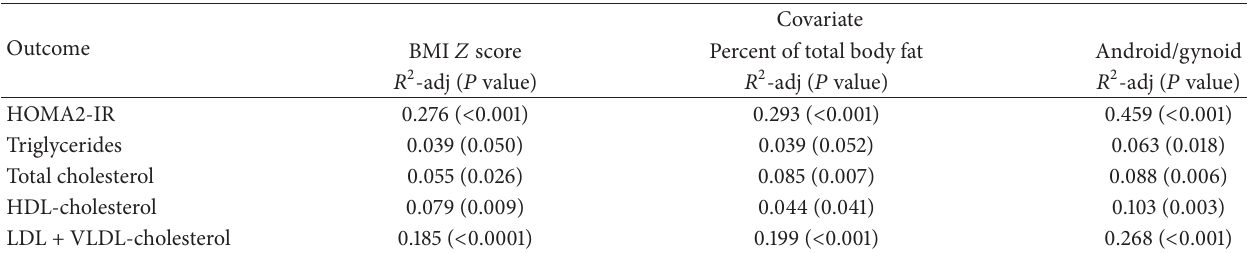
Table 2: Regression based correlation analyses adjusted 𝑅 2 for each outcome, HOMA2-IR, triglycerides, total cholesterol, and HDL- cholesterol and combined LDL + VLDL-cholesterol and each covariate BMI 𝑍 score, total body fat, and android/gynoid ratio.